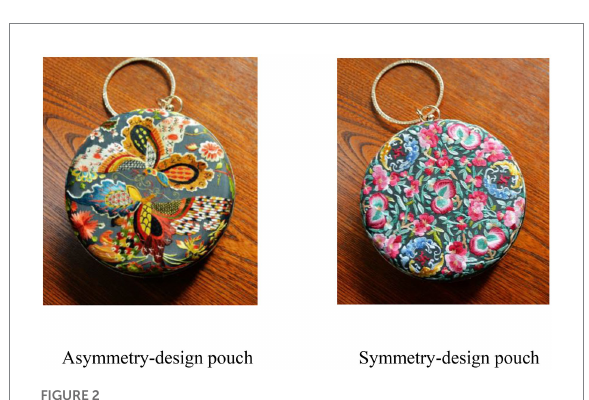
FIGURE 2 Picture of ICH souvenir stimuli used in Study